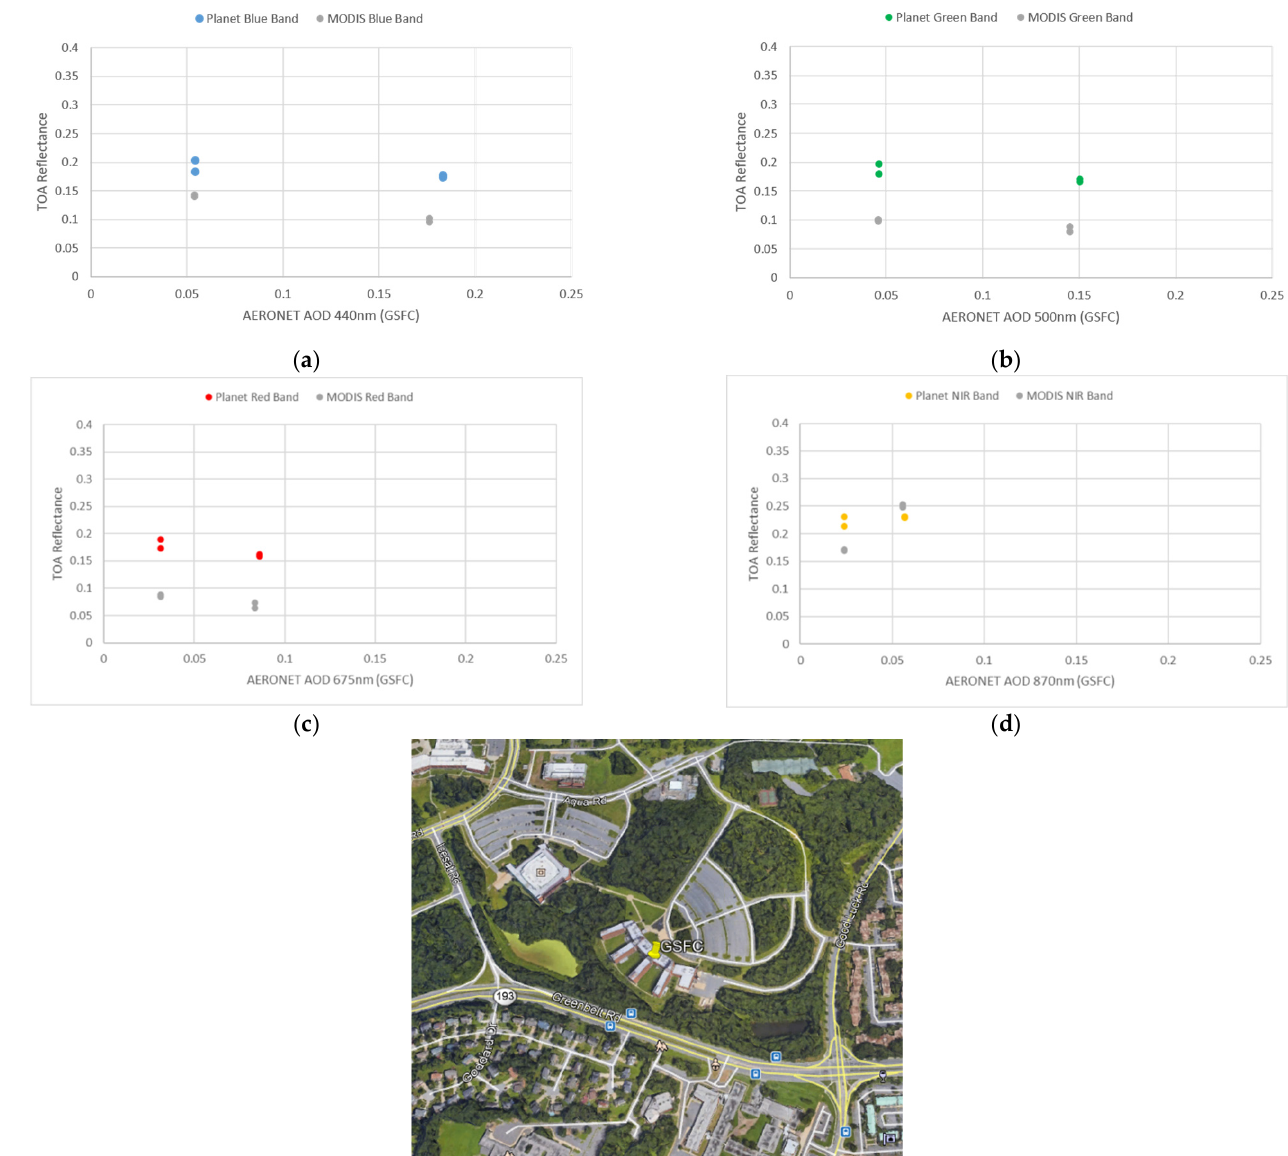
Figure A8. Data points from Figure 6 isolated for the GSFC AERONET site. Data points from the 5 × 5 and 10 × 10 pixel average plots are combined. Lower AOD values are from 3/22/2017 and higher AOD values are from 7/14/2018. Plots are separated by ( a ) blue band; ( b ) green band; ( c ) red band; ( d ) NIR band. PlanetScope values are in color and MODIS values are in grey. The image in ( e ) shows a screenshot of the AERONET site location in Google Earth.